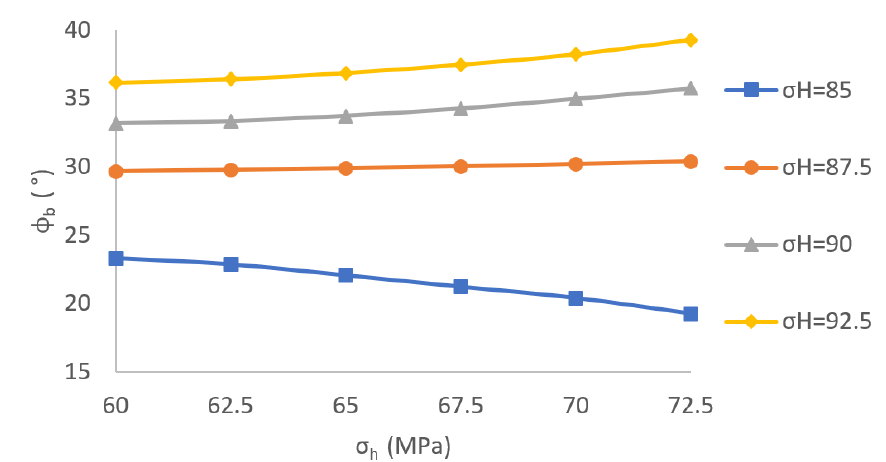
Figure 5. Breakout width for different in situ stresses.